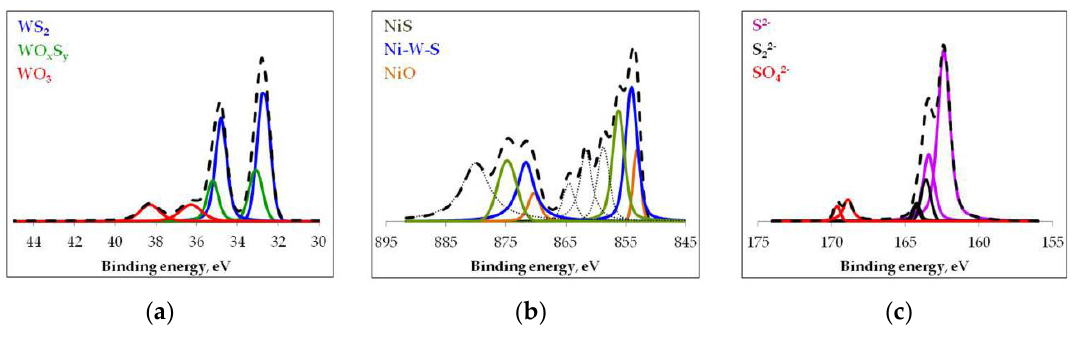
Figure 5. The ( a ) W 4 f , ( b ) Ni 2 p , and ( c ) S 2 p XPS spectra of the NiWS sample.